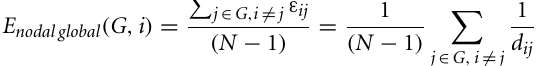
not meaningful; all regions are spatially contiguous. The cortical parcellation is based on anatomical landmarks, e.g., sulci. There are 78 cortical regions. These cortical regions serve as the nodes of the